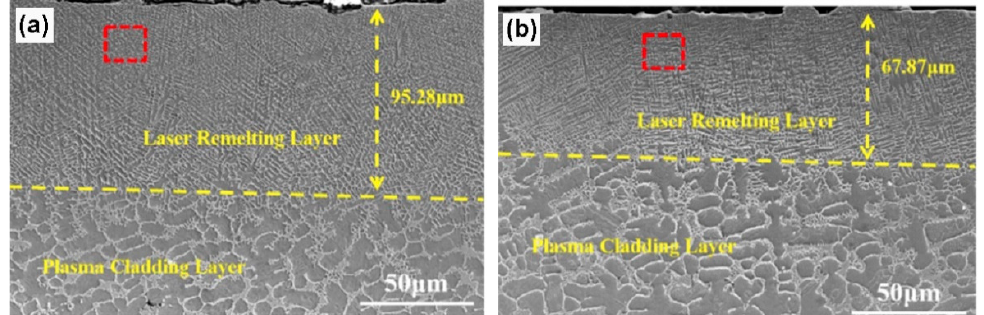
Figure 16. SEM images showing the cross-sections of the (FeCoCrNi) 75 Nb 10 B 8 Si 7 coatings. ( a ) LRM7. ( b ) LRM8. Reprinted with permission from ref. [108]. Copyright 2021